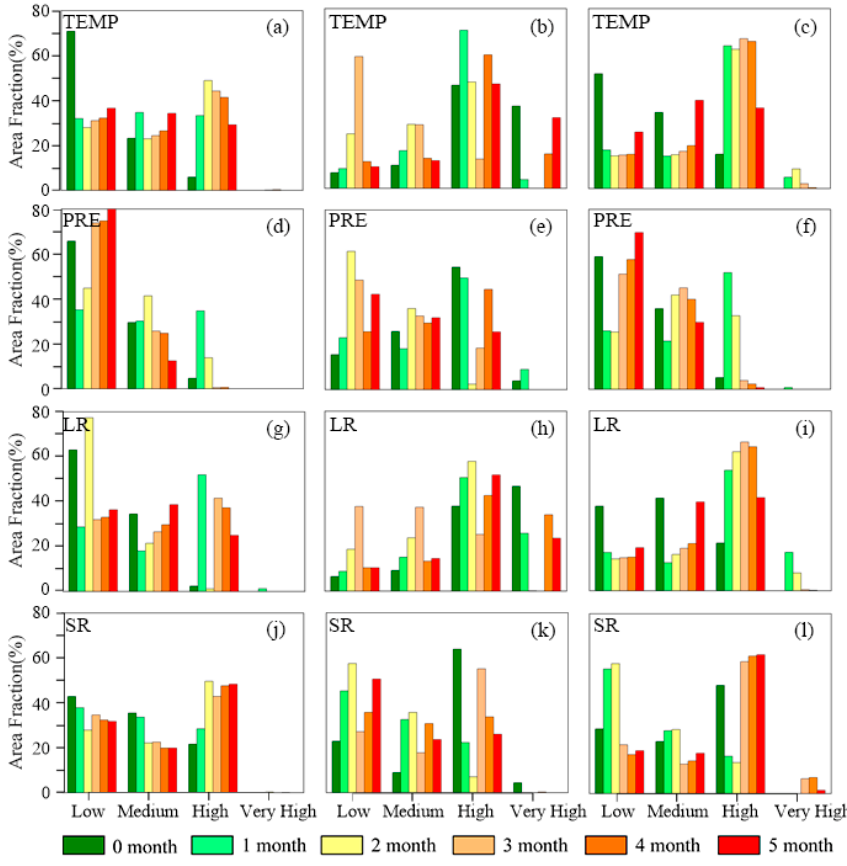
Figure 7. Statistics of area fractions of four levels under each climatic factor and each season: ( a ), ( d ), ( g ), and ( j ) for summer; ( b ), ( e ), ( h ), and ( k ) for autumn; ( c ), ( f ), ( i ), and ( l ) for the growing season.